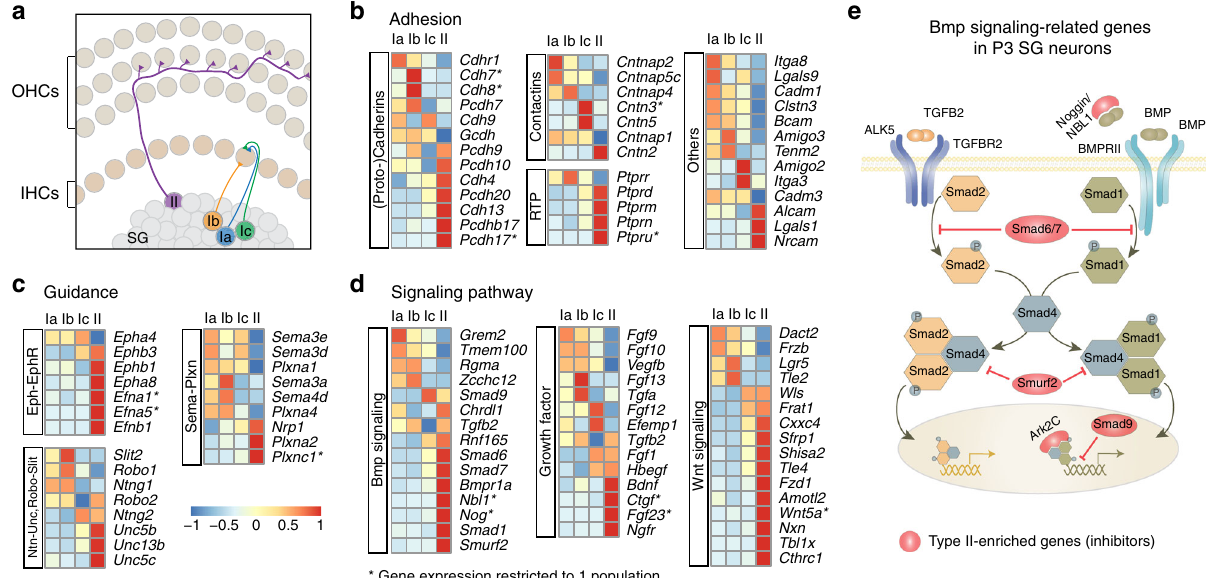
Fig. 7 Functional signature of neonatal SG neuron types. a Schematic illustration of the mature connection pattern of auditory afferents with HCs. A single type II afferent travels through the OHCs area and receives synaptic inputs from several OHCs. A single-IHC makes synaptic contact with several type I neurons. Ia and one Ic afferent contact the pillar side, and Ib afferent contact the modiolar side of IHC. b – d Differential expression of adhesion-related genes (RTP, receptor tyrosine phosphatase), of guidance molecules and of genes linked to key signaling pathways including Bmp signaling, Wnt signaling, and growth factors among SG neurons at P3 (see also Supplementary Fig. 9). e Schematic illustration of the Bmp signaling using gene expression data from P3 SG neuron types. Note in red the type II enriched expression of genes coding for inhibitory proteins of the Bmp